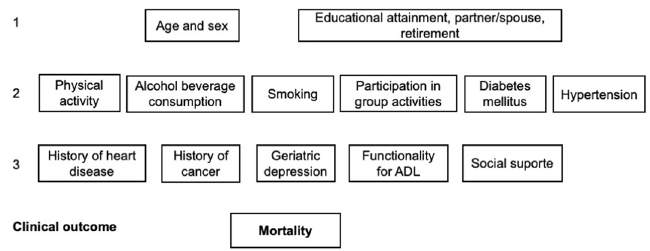
Figure 1. Hierarchical model of factors associated with mortality in older adults.